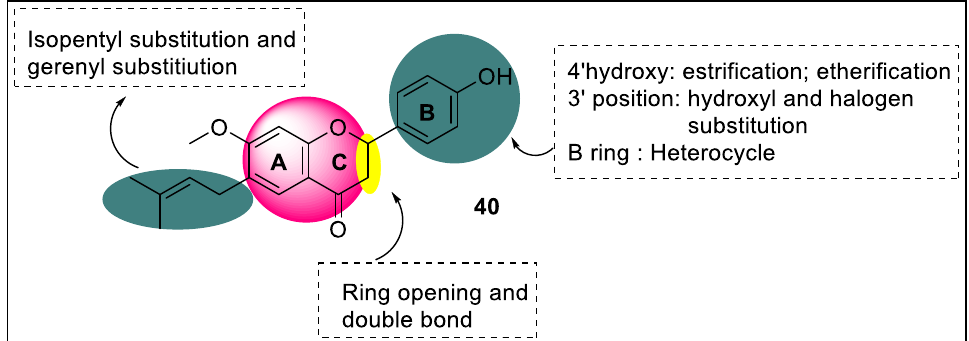
Figure 44. Series of bavachinin hybrids ( 40 ) as potent PPAR ligands.